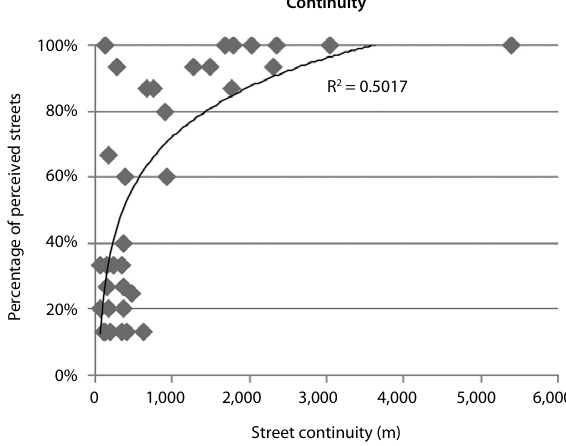
fig. 6. Comparison chart between street continuity and percentage of perceived streets in Kenmore and Kendall Sq.